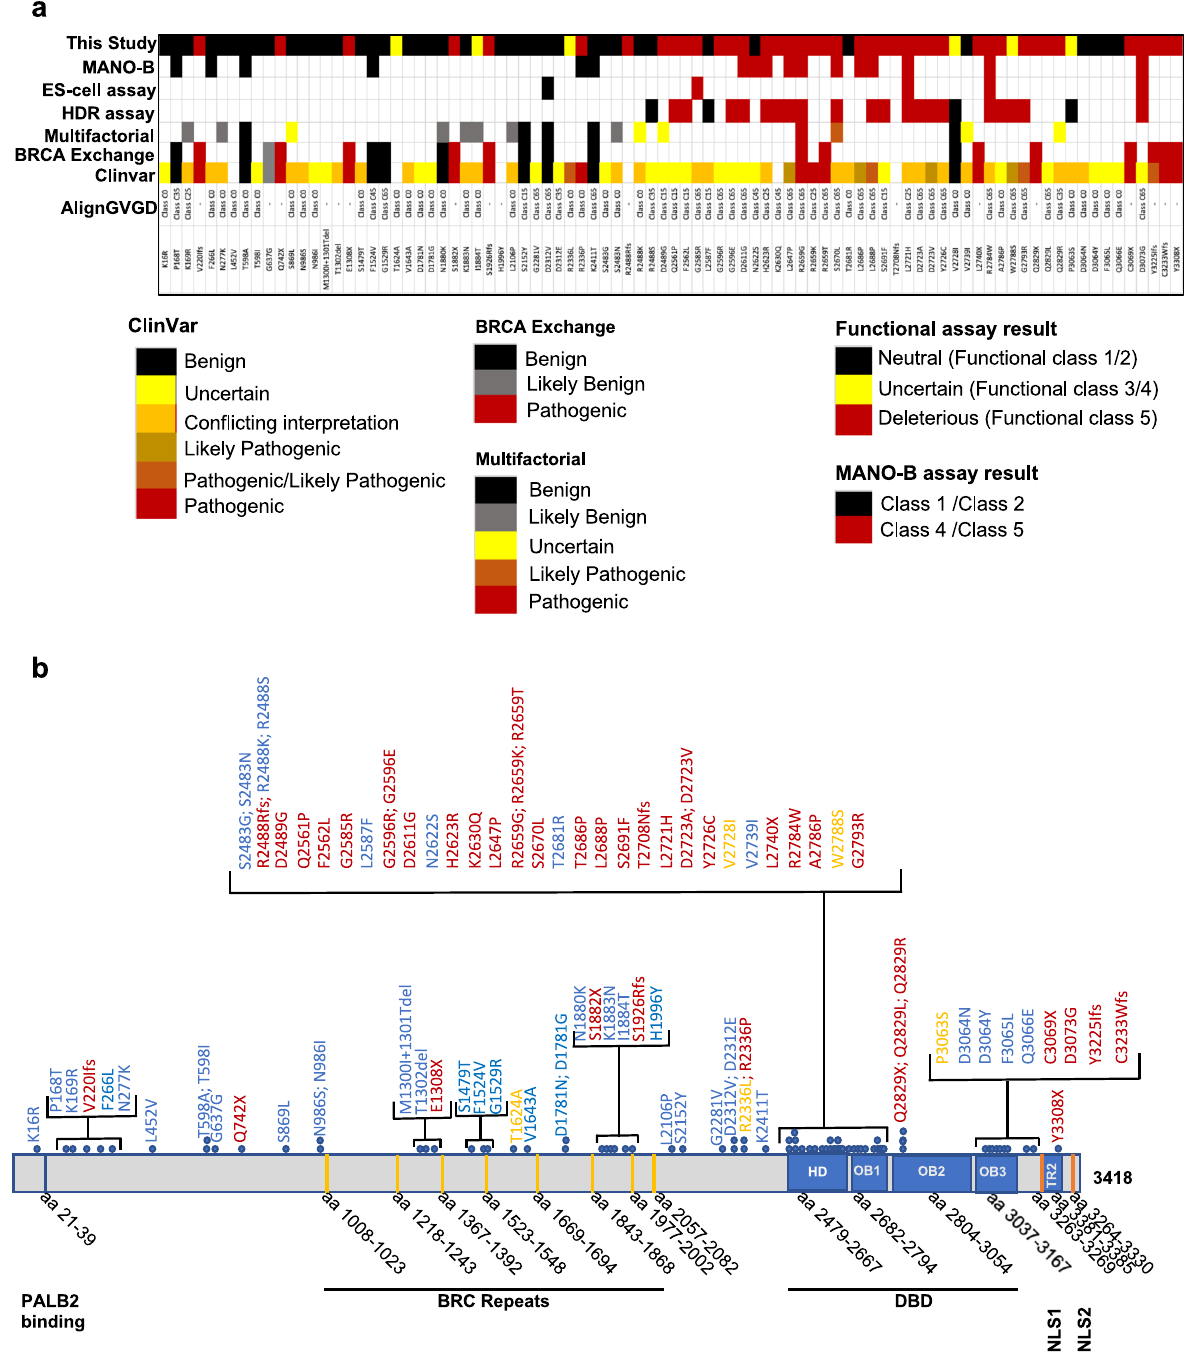
Fig. 6 Classi fi cation of variants analyzed using the VarCall method. a Variants analyzed using VarCall method are compared to ClinVar, Align GVGD, BRCA Exchange, classi fi cation by multifactorial likelihood ratio and published BRCA2 functional assays. Colored boxes represent different classi fi cations listed below. The MANO-B (mixed-allnominated-in-one (MANO)-BRCA) method of classi fi cation includes the classi fi cation by Ikegami et al. (2020), the ES assay includes the classi fi cation of variants using mouse ES cell-based assay reported by Mesman et al. (2019) and the HDR assay includes the classi fi cation of variants using HR assay reported by Guidugli et al. (2018) 18,19,33 . The Multifactorial classi fi cations are based on the study by Parson et al. 51 . b Schematic representation of classi fi ed variants in different domains of BRCA2. Neutral, hypomorphic and pathogenic variants are marked in blue, yellow, and magenta colors, respectively. Different domains are marked below with the range of amino acids (aa) containing in each